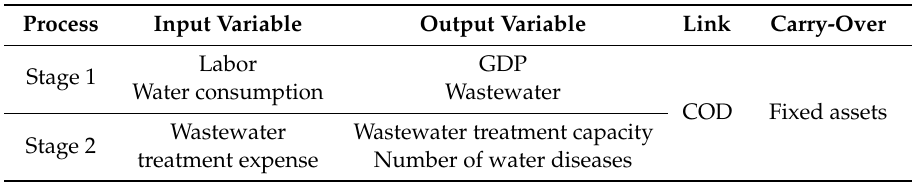
Table 1. Input and output